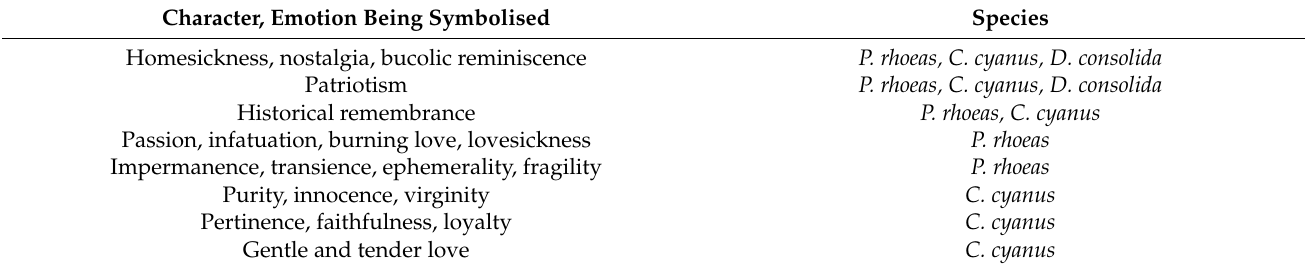
Table 4. Metaphorical connotations of the studied wildflowers symbolizing human characters and emotions (own synthesis based on the cultural uses presented in Section 3.5.1, Section